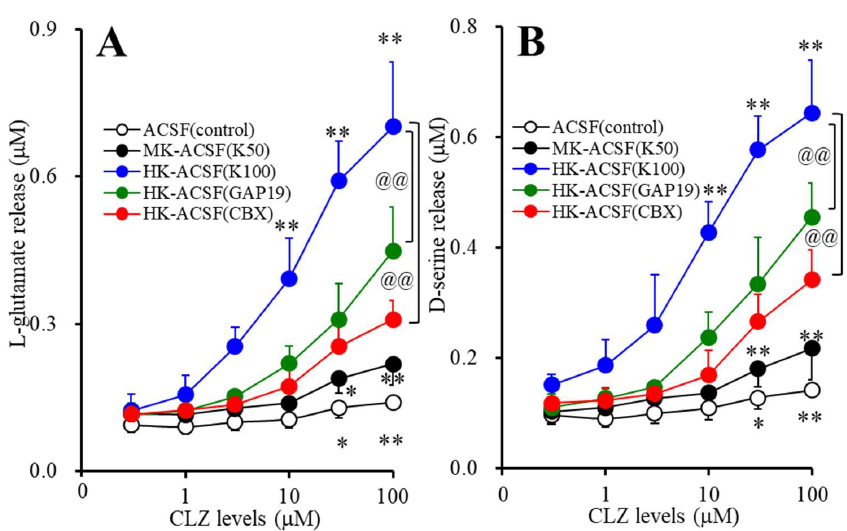
Figure 2. Concentration-dependent effects of subchronic administration of CLZ on basal and K + -evoked astroglial releases of L-glutamate (A) and D-serine (B). Astrocytes were incubated in Dulbecco’s modified Eagle’s medium containing 10% fetal calf serum (fDMEM) containing CLZ (0, 1, 3, 10, 30, or 100 μM) for 7 days. After wash-out, astrocytes were incubated in 100 μL ACSF containing the same concentration of CLZ for 60 min (pretreatment incubation). After pretreatment incubation, to determine the K + -evoked astroglial releases of L-glutamate and D-serine, astrocytes were incubated in ACSF (3.0 mM K + : opened circles), MK-ACSF (50.0 mM K + : closed circles), or HK-ACSF (100.0 mM K + : blue circles) containing the same concentration of CLZ during pretreatment incubation for 20 min. To clarify the astroglial releases of L-glutamate and D-serine associated with Cxs, astrocytes were incubated in HK-ACSF containing GAP19 (20 μ M) (green circles) or CBX (100 μ M) (red circles) with the same concentration of CLZ during pretreatment incubation for 20 min, and then incubate medium (ACSF, MK-ACSF, or HK-ACSF) was collected for analysis. Ordinate: mean±SD ( n = 6) of extracellular levels of L -glutamate and D -serine (μM). Abscissa: concentration of CLZ ( μ M). * p < 0.05 and ** p < 0.01